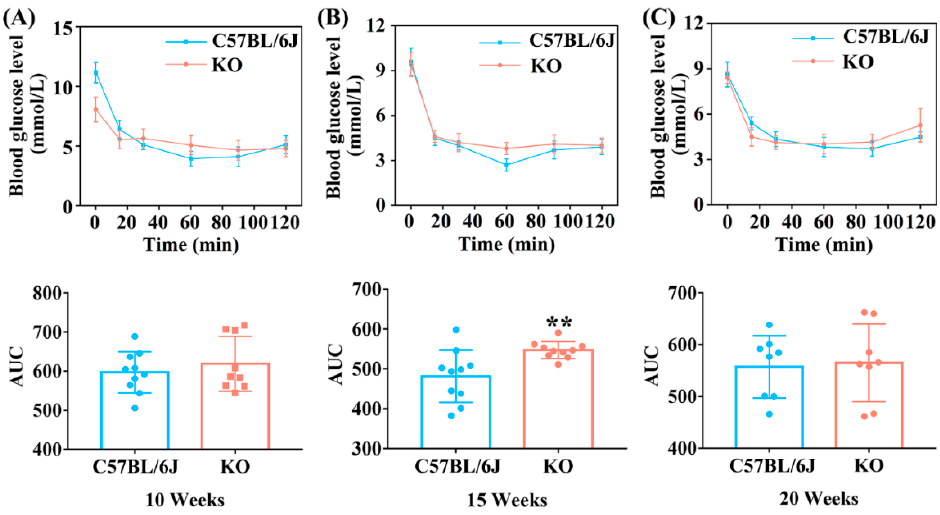
Figure 3. ITT (Insulin tolerance test) of KO and C57BL/6J mice at different ages. ( A ) ITT detected in 10 weeks ( n = 10 for C57BL/6J mice and n = 9 for KO mice). ( B ) ITT detected in 15 weeks ( n = 10). ( C ) ITT detected in 20 weeks ( n = 8). Data were expressed as mean ± SD. ** p < 0.01, compared with C57BL/6J mice.